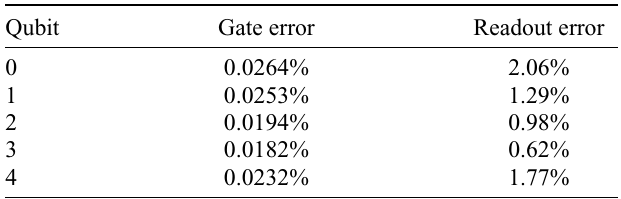
TABLE V. Single-qubit gate errors, and readout error data of the 5-qubit machine ibmq-santiago downloaded from the IBM Quantum system service at the time when the experiment is performed.